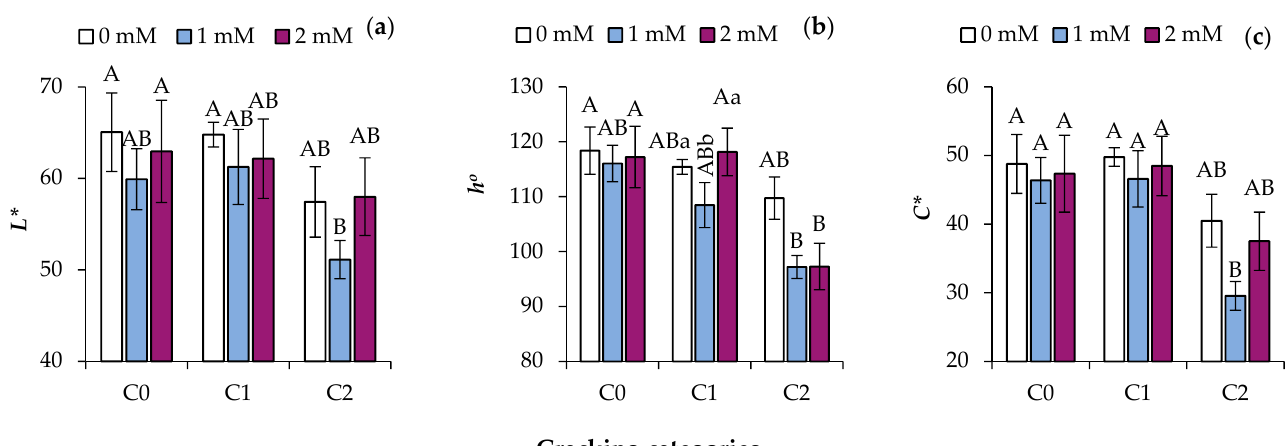
Figure 2. Changes in color parameters L* ( a ), h° ( b ), and C* ( c ) in cracking categories of fig peel after preharvest treatment with different concentrations of salicylic acid (SA), in year 1. Categories: C0, sound fruit; C1, slightly cracked; C2, highly cracked. All data presented are means (n = 3); bars are standard deviations. Columns not sharing a common letter are significantly different by Tukey test ( α = 0.05). Lowercase letters correspond to one-way ANOVA in each cracking category; capital letters correspond to one-way ANOVA of all data. Table 2. Probabilities of the effect of preharvest treatment with different concentrations of salicylic acid (SA) on L*, h°, C*, TSS, pH, and TA in fig flesh and TAN, C-3-rut, PAL , ANS , UFGT1 , and UFGT2 in fig peel in each cracking category (C0, C1, C2) and of all data differences on the same variables, in year 1.